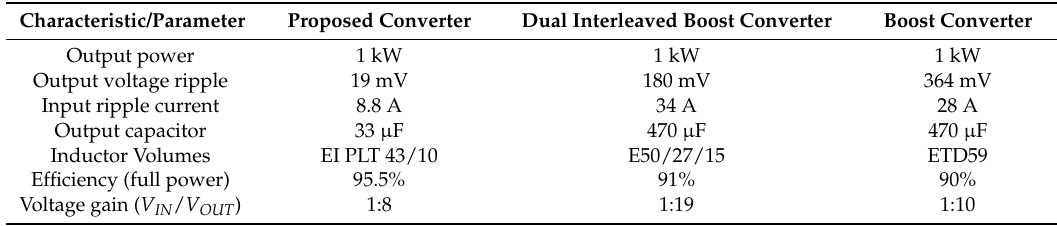
Table 7. Comparisons of proposed converter to other circuit